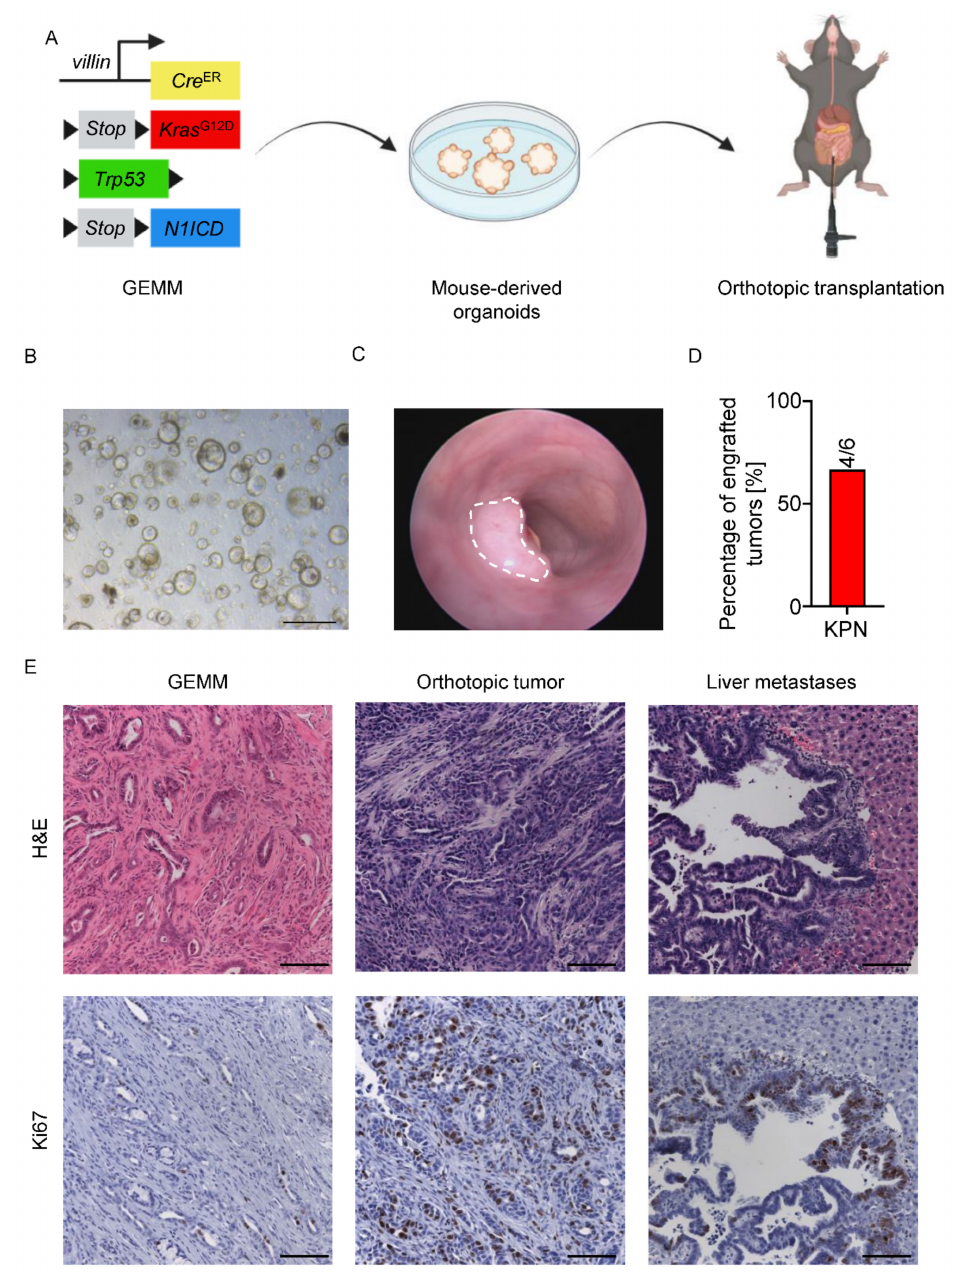
Figure 3. MDO generation and orthotopic transplantation. ( A ) Schematic representation of the generation of tumor-derived organoids from GEMMs and orthotopic transplantation of those MDOs. ( B ) Bright field image of KPN MDOs. Scale bar indicates 500 µ m. ( C ) Representative colonoscopy image of a tumor derived from KPN MDOs two weeks post transplantation. ( D ) Percentage of engrafted tumors from KPN MDOs. ( E ) Representative H&E (top) and Ki67 (bottom) images of KPN GEMM, orthotopic tumors, and liver metastases originated from the orthotopic tumor. Scale bars indicate 100 µ